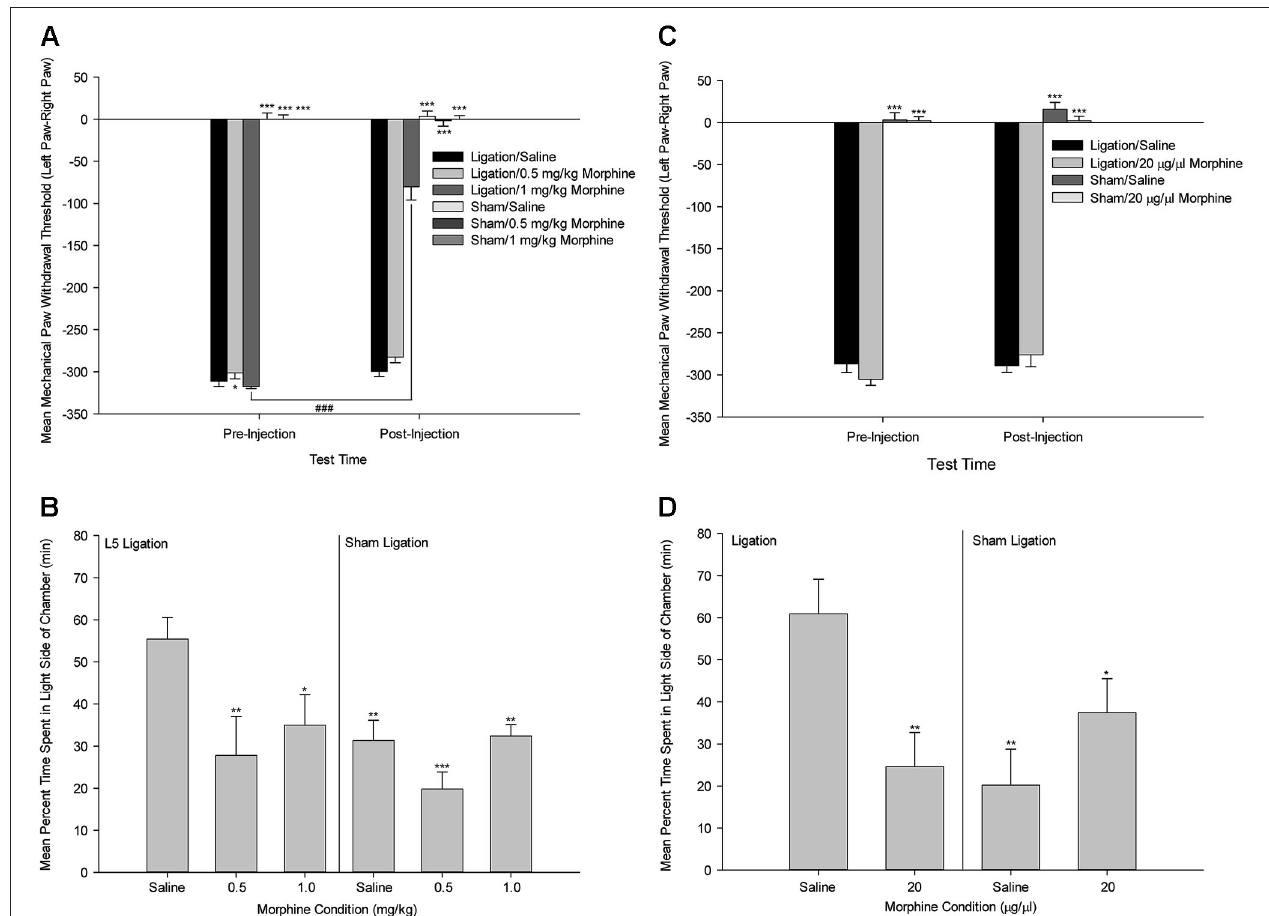
### p < 0.001 versus same group at pre-injection time point. (C) Mean ± SEM mechanical paw withdrawal threshold difference scores (left paw–right paw) prior to and following microinjection (Saline, 20 µ g/ µ l morphine) into the ACC for animals with sham ligation or ligation of the L5 spinal nerve. (D) Mean ± SEM percentage of time within the light side of the test chamber for the duration of the 30-min test period following microinjection (Saline, 20 µ g/ µ l morphine) into the ACC for animals with sham ligation or ligation of the L5 spinal nerve. * p < 0.05 versus Ligation/saline; ** p < 0.01 versus Ligation/saline; *** p < 0.001 versus Ligation/saline (Reprint from LaGraize et al.,